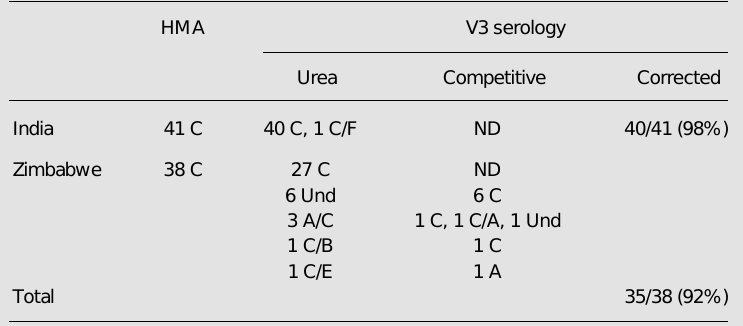
Table 4. Results obtained by HMA, EIA-peptide, and EIA-peptide competition in samples from India and Zimbabwe.